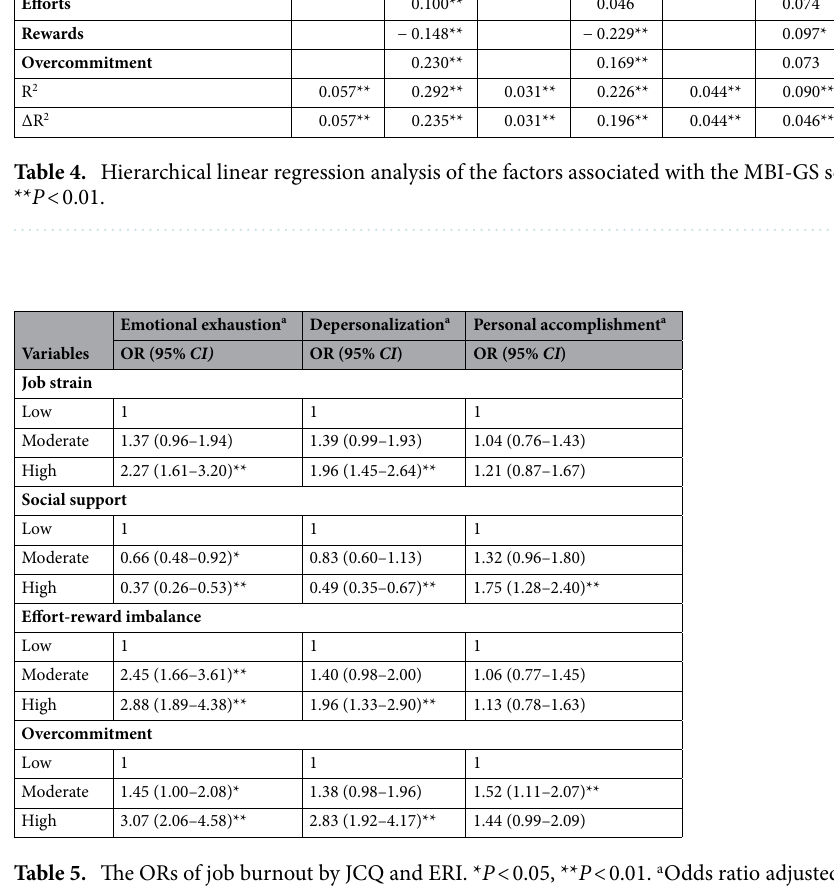
Table 5. The ORs of job burnout by JCQ and ERI. * P < 0.05, ** P < 0.01. a Odds ratio adjusted by age, marital status, educational level, monthly income, shift work, assembly line, working years, and exposure to occupational